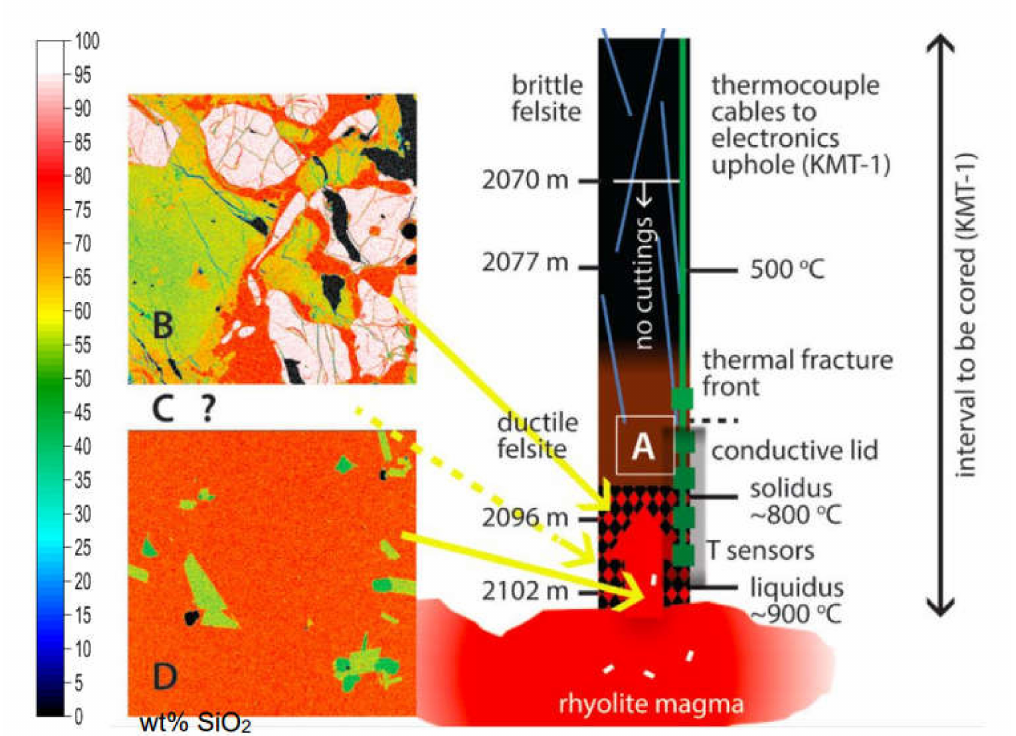
Figure 5. Important observations from the IDDP-1 borehole and 1 mm × 1mm Si element maps of the two lithologies represented in chips from the bottom of the well, color coded in wt% SiO 2 (bar at left). B is partially melted felsite, C is expected but missing mush, i.e., partially crystallized magma, and D is near-liquidus rhyolite magma. Although a layered sequence is shown, it is possible that lithology B occurs only as xenoliths (Figure 4) within the magma ( D ). Photo credit: N. Graham and P. Izbekov at University of Alaska Fairbanks’s Advanced Instrumentation Laboratory. Also shown are plans for KMT-1 to obtain continuous core (black double-headed arrow) and a temperature profile from a thermocouple string (green line) through the same